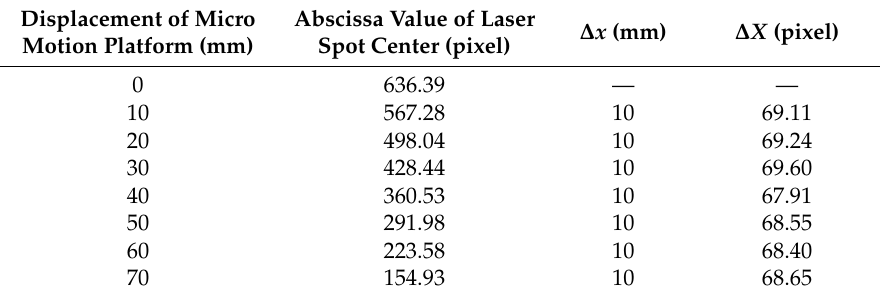
Table 1. x -axis conversion coefficient calibration experimental data.